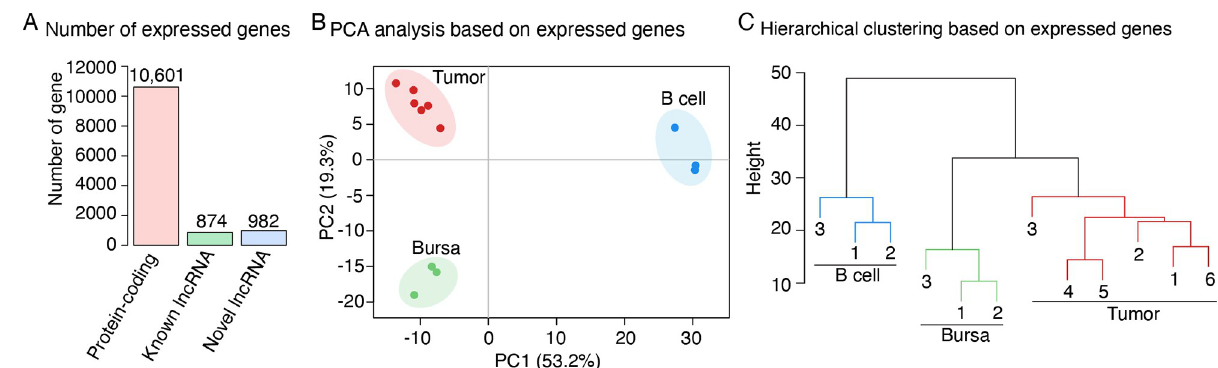
Fig 2. Cluster analysis of the samples. (A) A total of 12,457 genes including 10,601 protein-coding genes, 874 known lncRNAs and 982 novel lncRNAs with raw reads counts > 10 in at least 4 samples from at least one group were used for clustering and differential expression analysis. (B) Principal component analysis (PCA) of all samples based on the 12,457 expressed genes. Samples from the same group are indicated by a same color. (C) Hierarchical clustering results of all samples based on the 12,457 expressed genes. Spearman’s correlation was used as distance metric with the average linkage